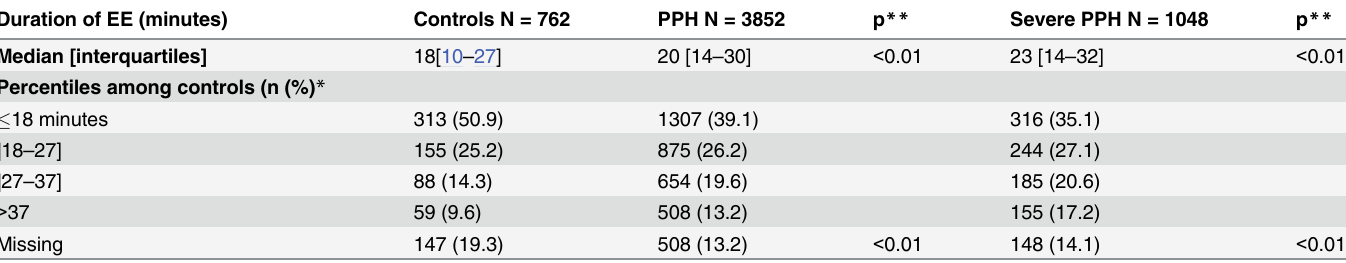
Table 2. Duration of expulsive efforts (EE) among cases and